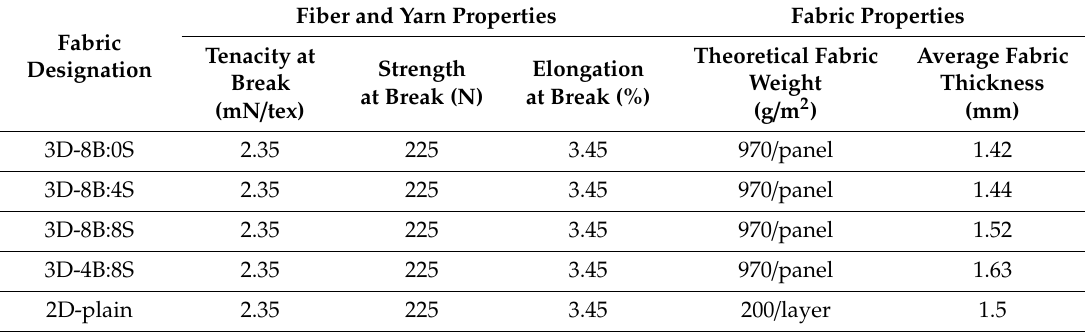
Table 1. Specification of high-performance para-aramid fiber and the produced 3D warp interlock fabrics.